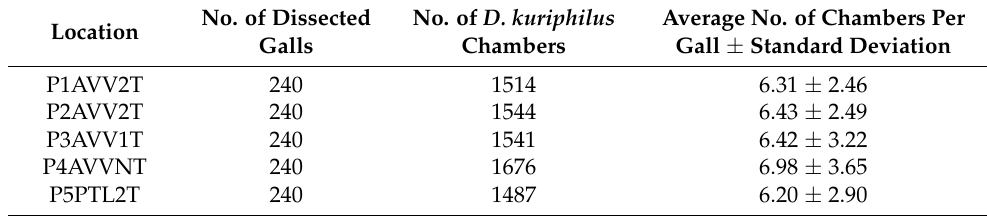
Table 3. Results of the dissection of spring galls harvested in 2018 in the five chestnut orchards (P1 to P5) located in Arcos de Valdevez (AVV) and Ponte de Lima (PTL), with one (1T), two (2T) or no treatment (NT) of T. sinensis .